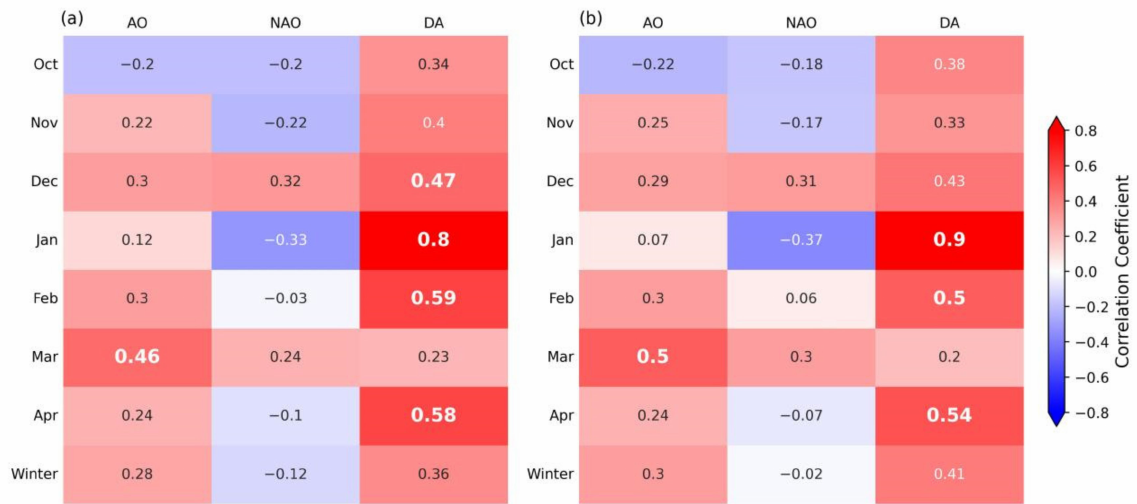
Figure 8. CCs between atmospheric indices and total sea ice areal flux through Fram Strait ( a ) and of the Arctic ( b ).